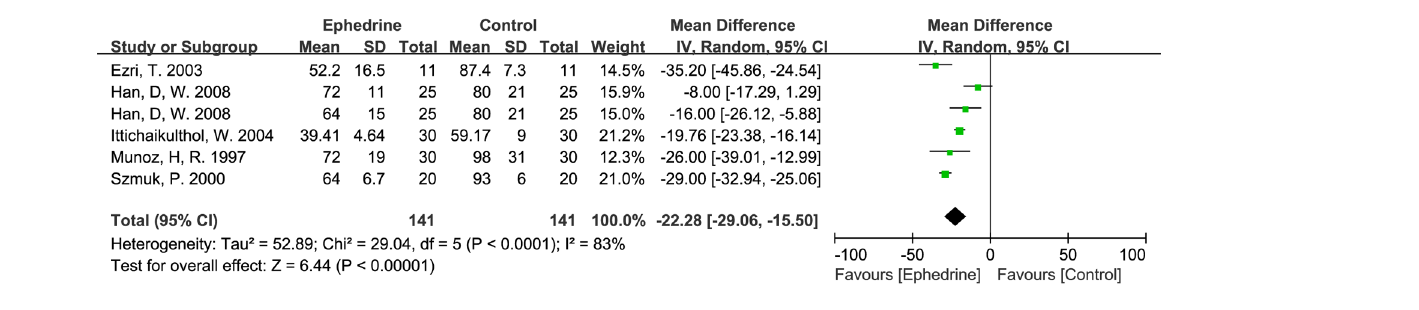
Figure 5. Effects of pretreatment with ephedrine on rocuronium onset time.